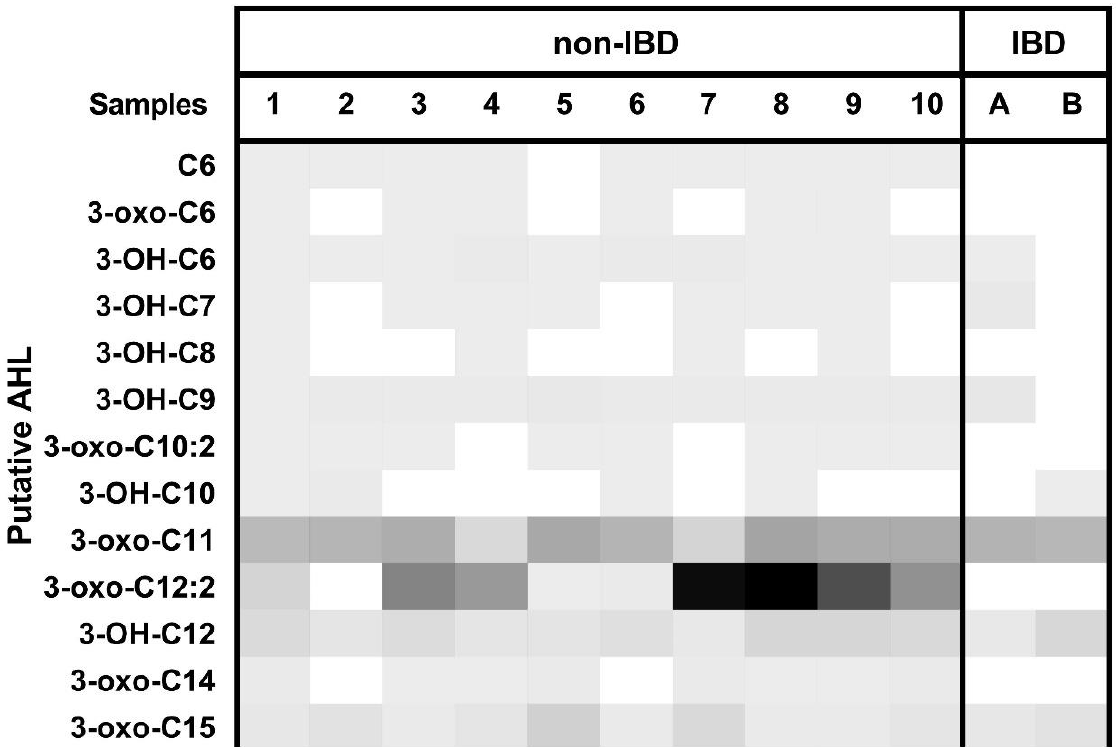
Figure 1. Heatmap of putative AHL profiles in non-IBD controls and IBD patients. The grey color bar intensity indicates the AHL m / z integrated peak area from zero (white) to the highest concentration (black). IBD: inflammatory bowel disease patients. Numbers and letters represent sample names.